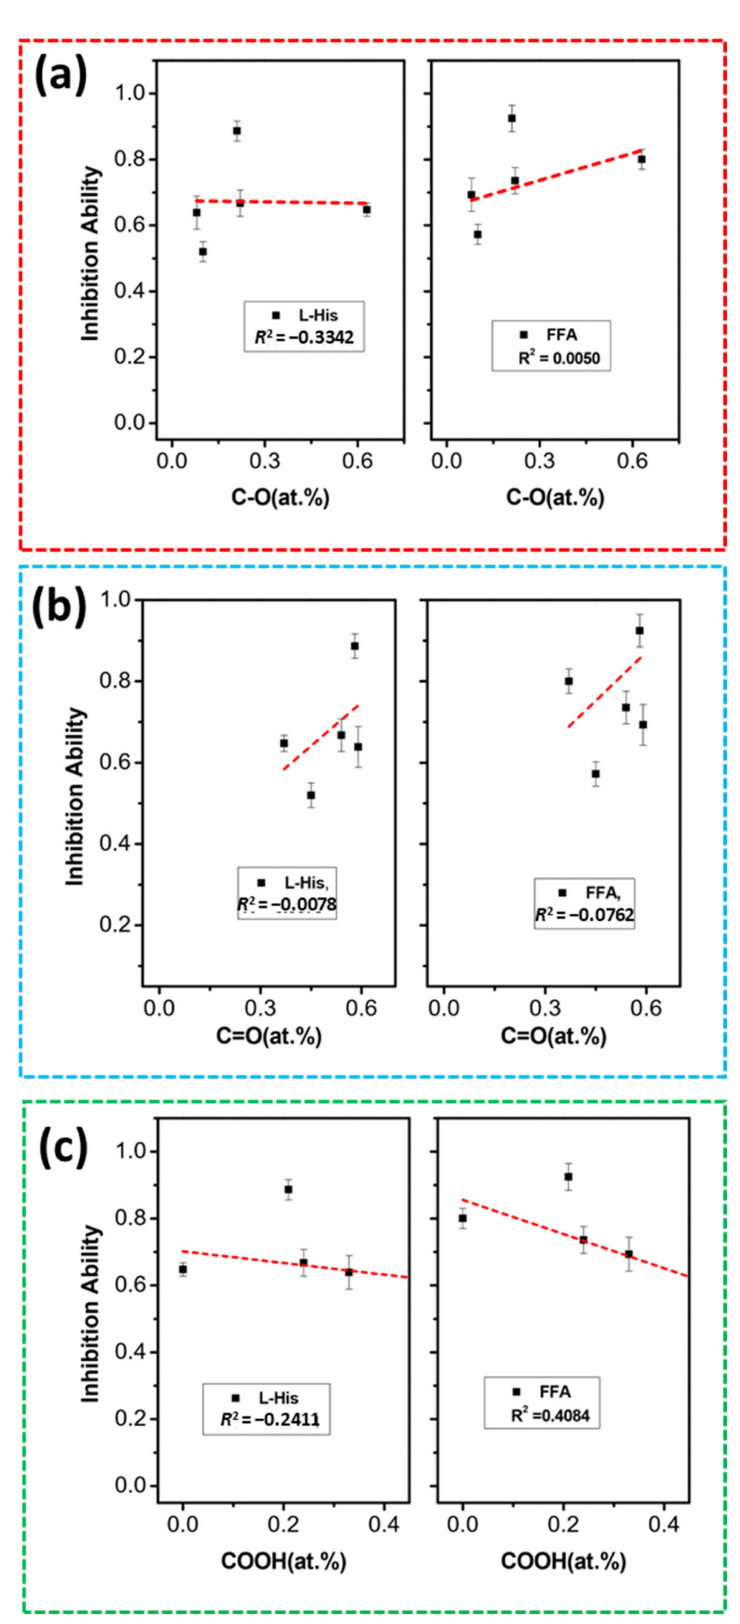
Figure 9. Role of singlet oxygen ( 1 O 2 ) on ACP degradation rate ( k 1 ). Correlation between k 1 and -C-O ( a ), k 1 and -C=O ( b ) and k 1 and -COOH ( c ). Quenching studies were carried out at C ACP = 10 mg L − 1 , C Catalyst = 100 mg L − 1 , C PMS = 0.5 mM, C FFA = C L-His = 50